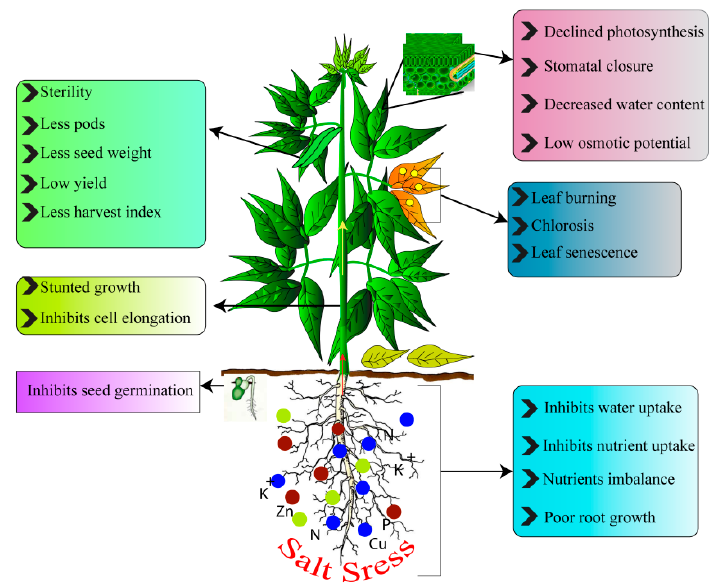
Figure 1. Schematic representation of plant response to salt stress (SS).